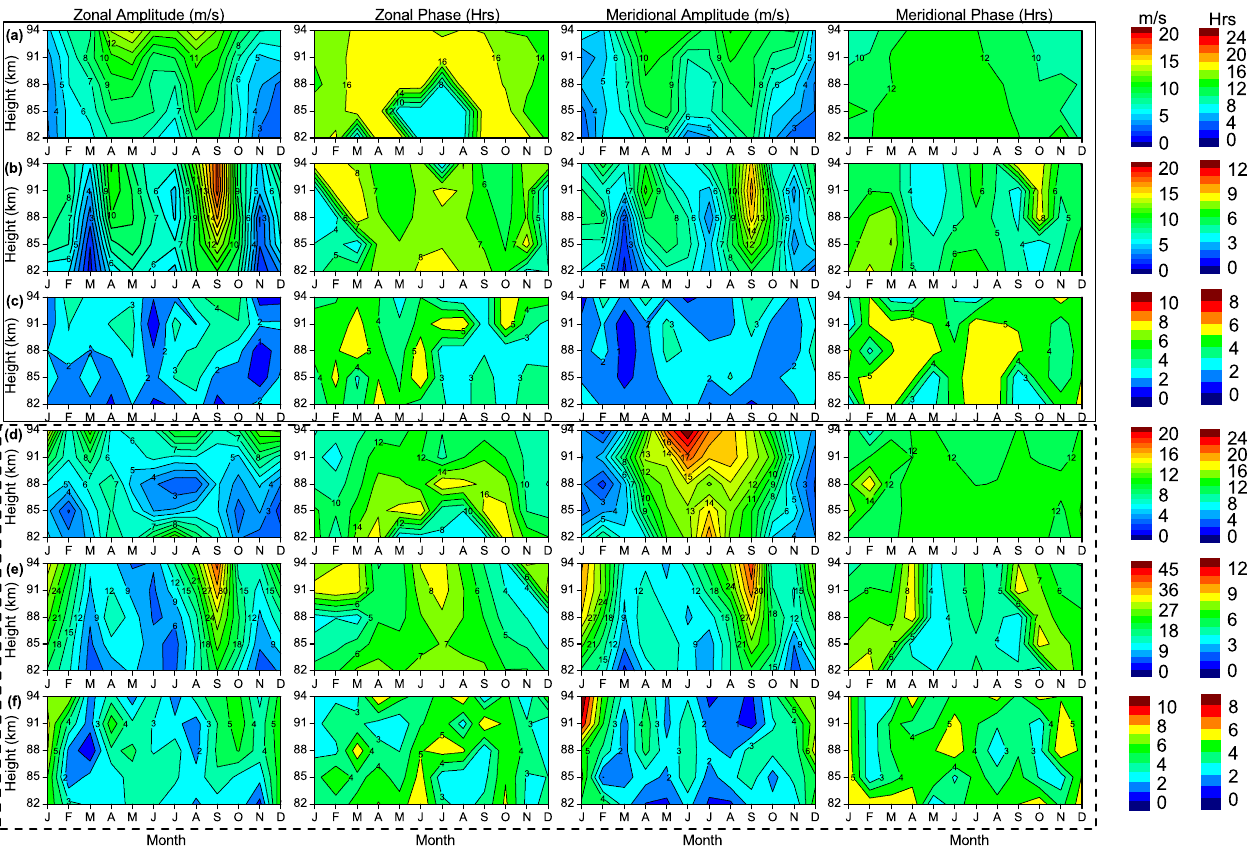
Fig. 4. Climatological monthly mean variations of zonal amplitude, zonal phase, meridional amplitude, and meridional phase (a–c) for diurnal, semidiurnal and terdiurnal tide over RB. (d–f) similar to (a–c) but for YK. Note that the first color bar is meant for amplitude and the second color bar is meant for